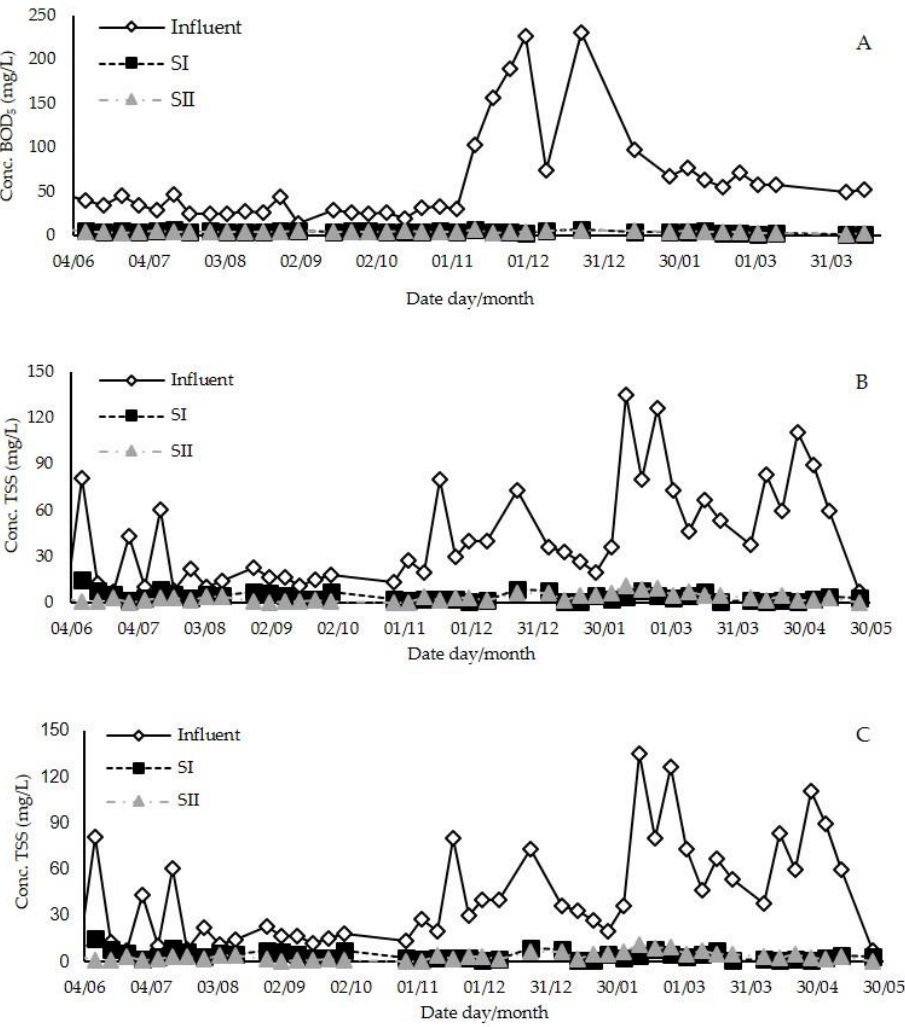
Figure 2. Behavior of BOD 5 ( A ), COD ( B ) and TSS ( C ) in the two PS VF wetlands along the study.